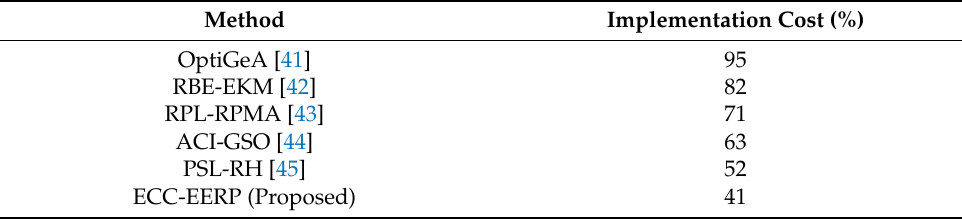
Figure 10. Implementation cost of the proposed and existing methods [41–45]. Table 9. Implementation cost of the proposed and existing methods .